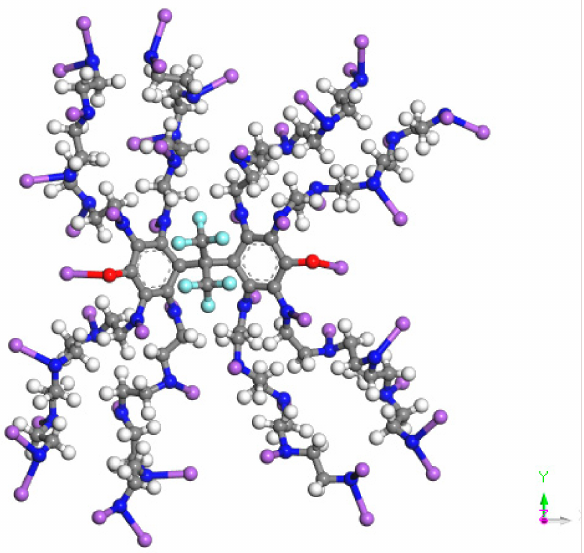
Figure 1. Schematic diagram of optimized molecular structure, where blue is N, red is O, white is H,